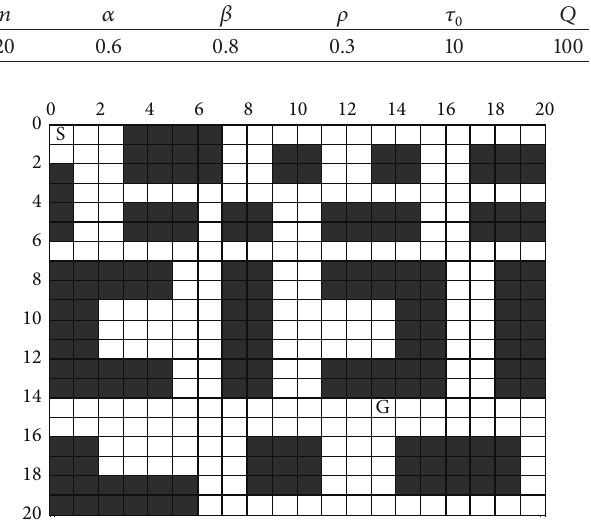
Figure 12: Environment map